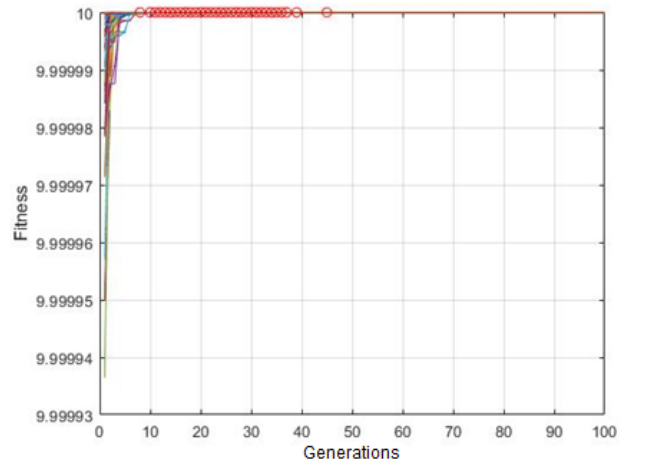
Figure 12. Fitness for the FEC.